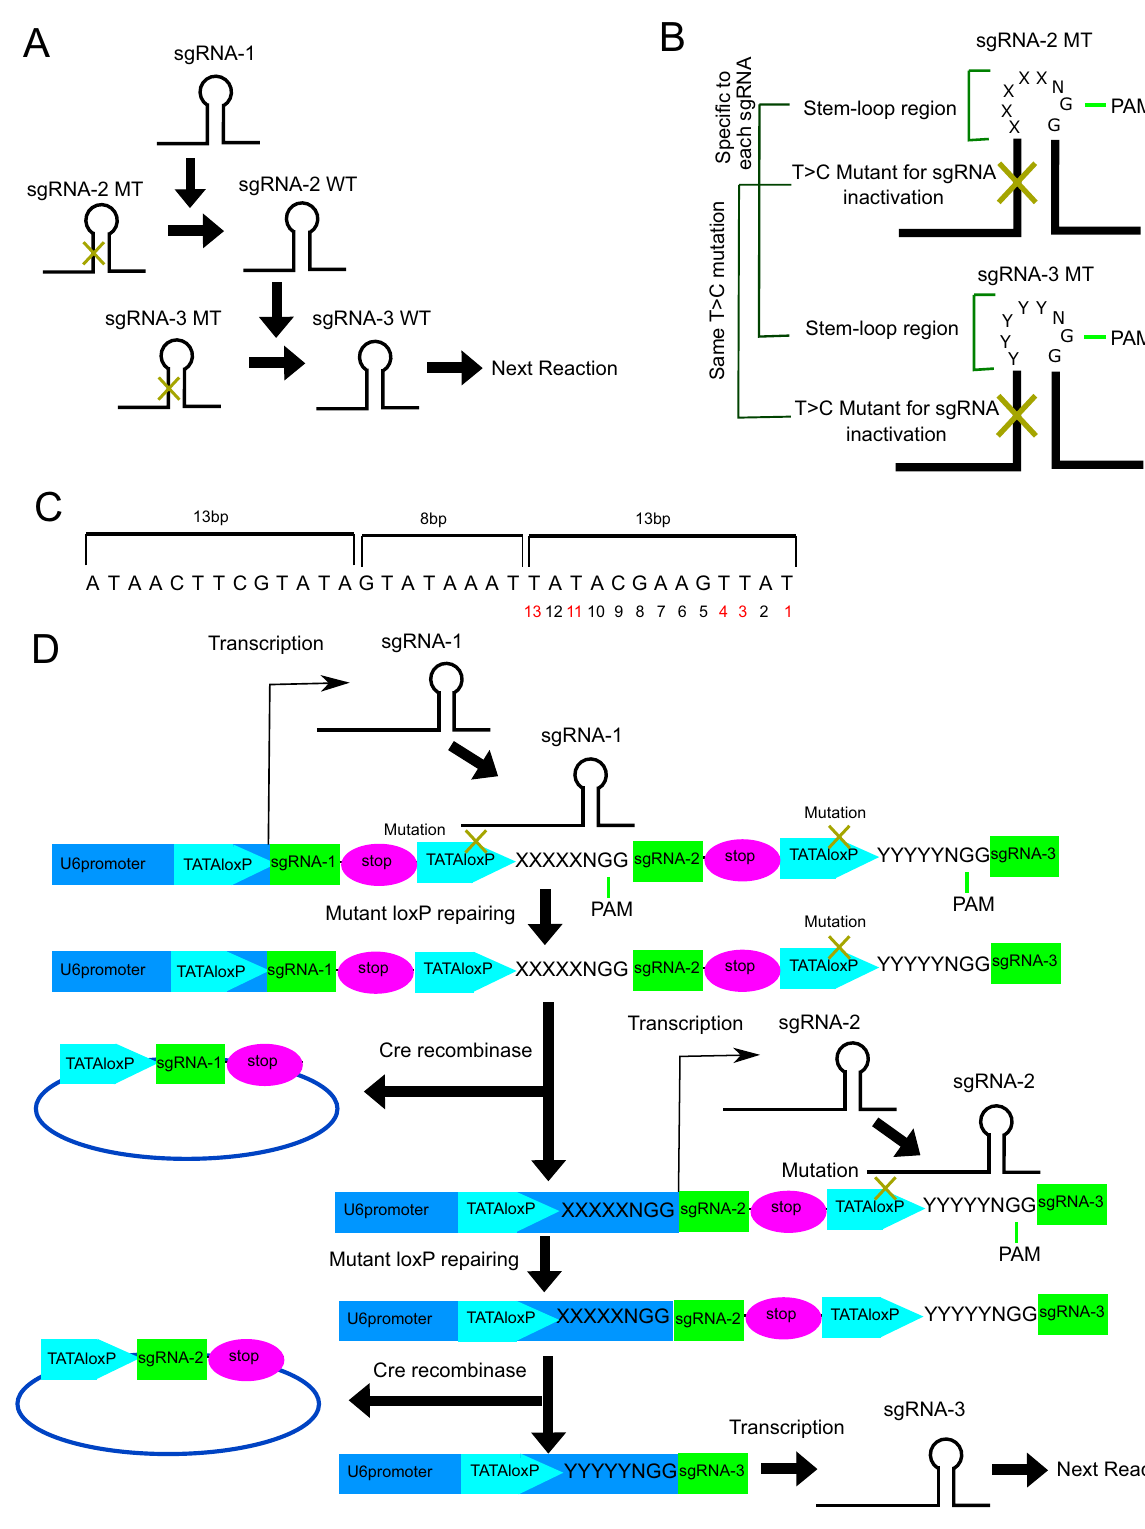
Figure 1. Screening of inactive sgRNAs with scaffold mutations in yeast. ( A ) Schematic representation of the chain reaction with nCas9-CDA and sgRNAs with scaffold mutations. ( B ) Schematic representation of the sgRNA structure with the T > C mutation and specific sequences in the stem-loop region. ( C ) Schematic representation of TATAloxP structure and sequences. ( D ) Schematic representation of chain reaction with nCas9-CDA and TATAloxP with T > C